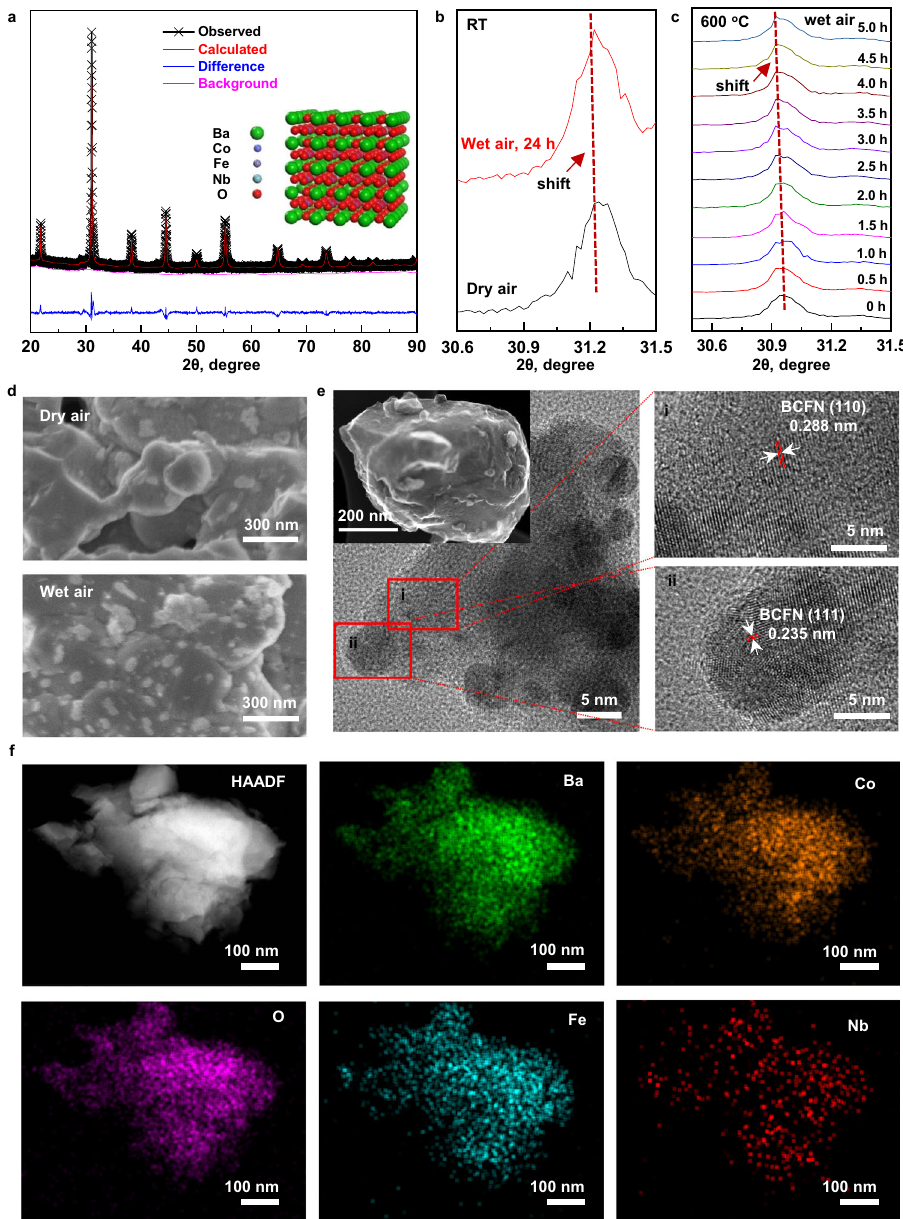
Fig. 2 Structural characterization of BCFN powder. a A Rietveld re fi nement of XRD patterns for a BCFN powder with measured data (black dots), simulated (red line; calculated pro fi le), background (pink line), difference curves (blue line), and a schematic of a BCFN crystal structure (inset). The powders were calcined at 1100 °C for 2 h in the air; b Room temperature XRD patterns of the BCFN powders after a treatment at 650 °C in dry air and wet air (24 h, 3% H 2 O); c XRD patterns (collected at 600 °C) of the BCFN powders treated in wet air; d SEM images of BCFN powders before (top) and after (bottom) exposure to the wet air (3% H 2 O) at 650 °C for 2 h; e High-resolution TEM images of BCFN grains, including BCFN substrate and BCFN NPs; f High-angle annular dark- fi eld STEM image from the BCFN powders, and the X-ray energy dispersive spectrum mapping of Ba, Co, O, Fe, and electrolysis mode and the R-PCECs can achieve high fuel utili- zation and ef fi ciency in the fuel cell (FC) mode; 30 in contrast, fuel dilution is unavoidable in an oxide-ion conductor based cell 31 . Shown in Fig. 2a are the XRD patterns of BCFN with no detectable impurities. An XRD re fi nement of the BCFN crystal (cid:1) structure displayed a typical perovskite structure ( Pm 3 m ), with a reasonable reliability fi tting factors of 1.83. It is noted that no impurities were detected in the mixture of BZCYYb and BCFN ( fi red at 1000 °C for 2 h in the air), indicating good chemical of BCFN samples treated in dry and wet air (Fig. 2d). Shown in compatibility between BZCYYb and BCFN (Supplementary Fig. 2e are the high-resolution TEM images of BCFN powders, Fig. 1). Slight shifts of the main peak of the BCFN sample were treated in the air with 3% H 2 O for 24 h. The lattices with spacing